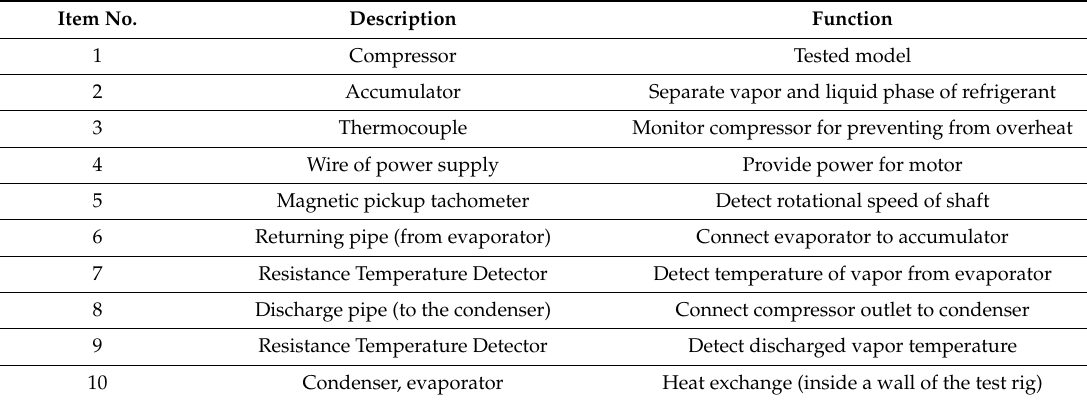
Figure 5. Compressor test rig: ( a ) facility ( b ) arrangement. Table 1. Major components of testing facility.